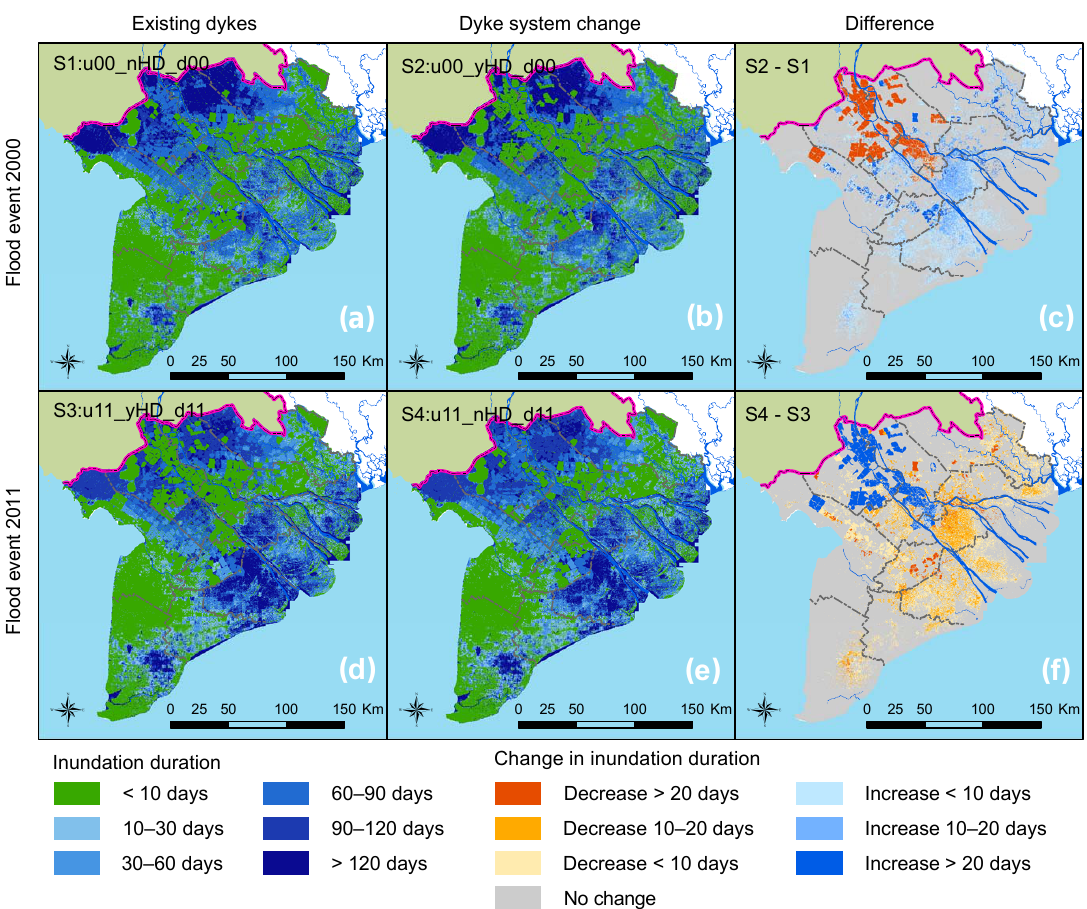
Figure 9. Impacts of upstream high-dyke development on downstream inundation duration for the flood event 2000 (a, b, c) and the flood 2011 (d, e, f) . (a, d) Dykes as existing in the respective year. (b, e) Dyke system interchanged between the two years. (c, f) Difference between the two dyke